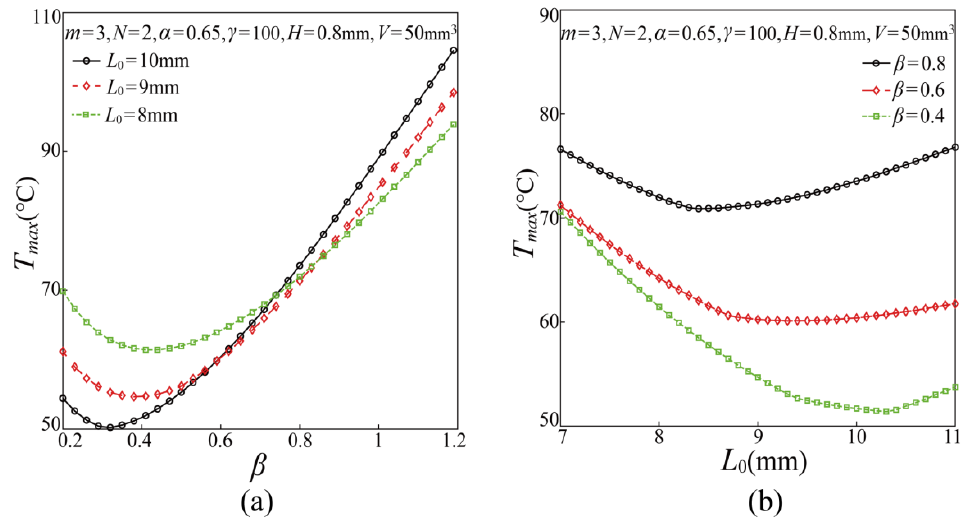
Figure 4. ( a ) Effect of β on the maximum temperature of the chip with different value of L 0 ( b ) Effect of L 0 on the maximum temperature of the chip with different value of β .